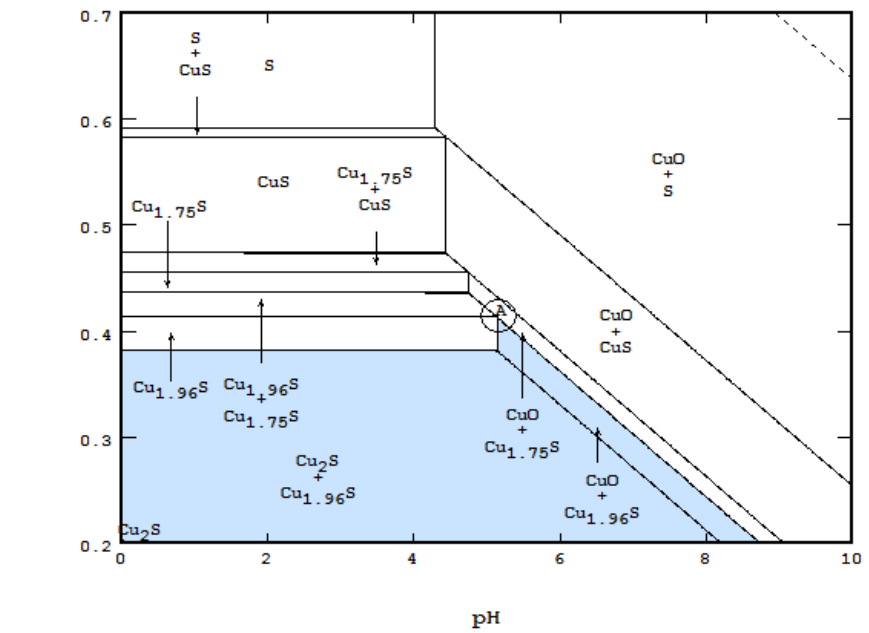
Figure 17. Mass-balanced Eh-pH diagram of the Cu–S–water system to illustrate the phase rule. This is a zoomed-in detail from Figure 14; stable solids include elemental S from the S component. ΣCu = 0.118 and ΣS = 0.059 M.